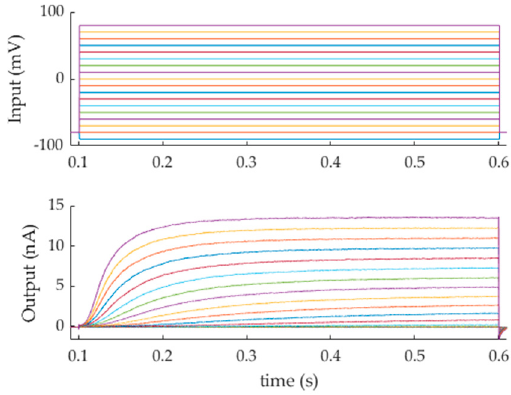
Figure 4. Input: activation voltage step protocol ( above ); output: measured macroscopic ion-current ( below ) for system identification.